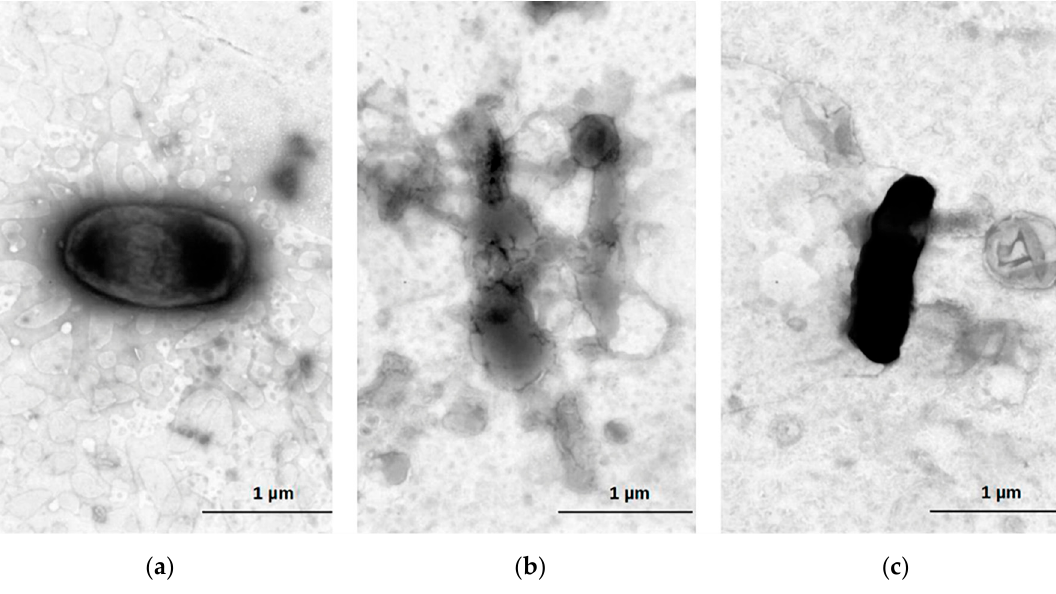
Figure 8. Cell death after exposure to liposome encapsuled lysins. Electron microscopy of P. aeruginosa ATCC 27853 treated with lysins encapsulated in liposomes. Untreated P. aeruginosa ( a ); P. aeruginosa treated with 100 µg/mL lysin Pa7 ( b ) and lysin Pa119 ( c ) after 120 h. Cells were negatively stained using 1% aqueous uranyl acetate.